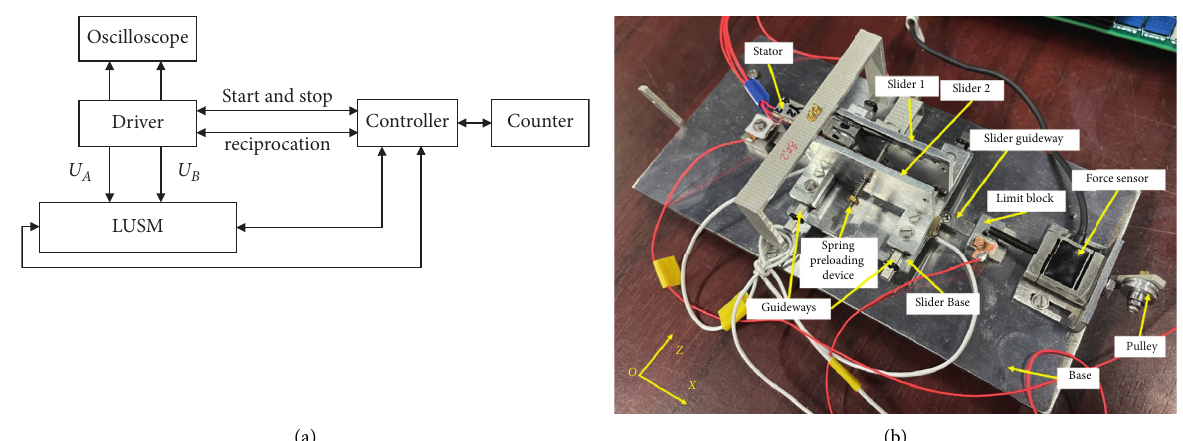
Figure 14: Reciprocation control and experimental setup of LUSM. (a) Control block of LUSM reciprocation. (b) Experimental setup of LUSM.